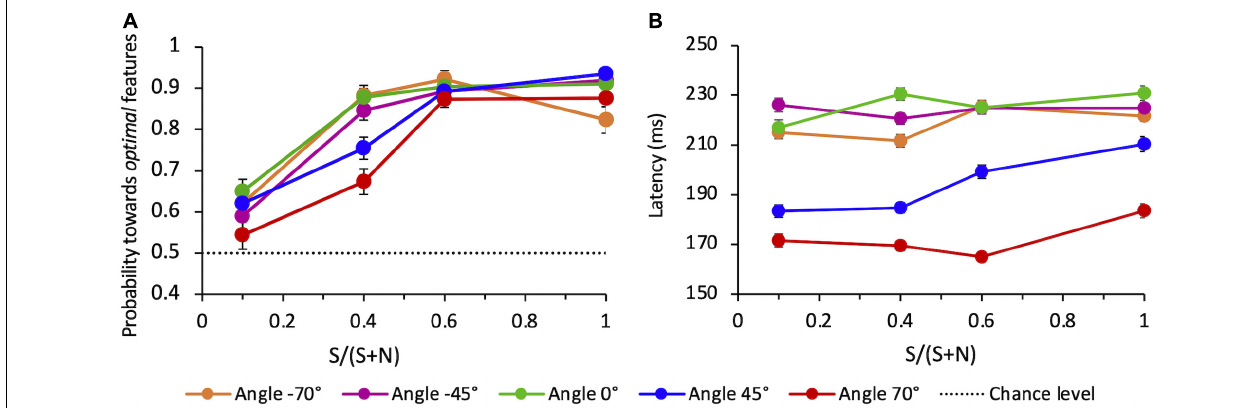
FIGURE 9 | (A) Average probability of correct saccades as a function of SNR at different angles. Data are pooled across observers (weighted means with their errors). The dashed line indicates the guessing level for this task (0.5 probability). (B) Average latency of correct saccades as a function of SNR at different angles. Averages are taken over all correct trials (classified as “to-the-target”) and all observers (weighted means with their errors).